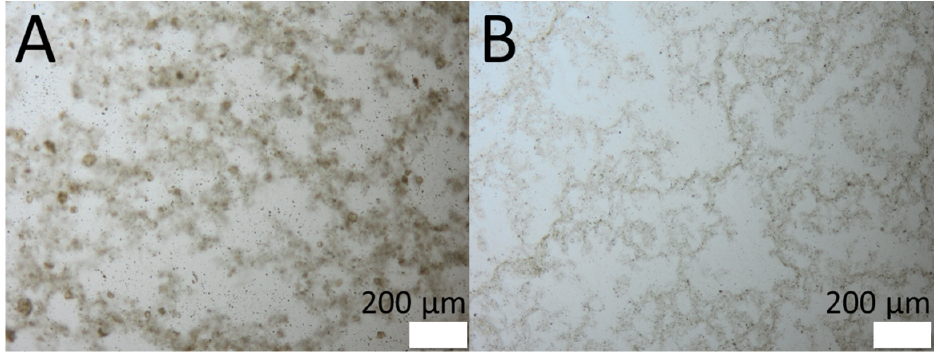
Figure 3. Light microscopic images of processed stinging nettle (SN) PlantCrystals samples. Magnifi- cation: 100-fold. ( A ): Without additional surfactant. ( B ): With TPGS as